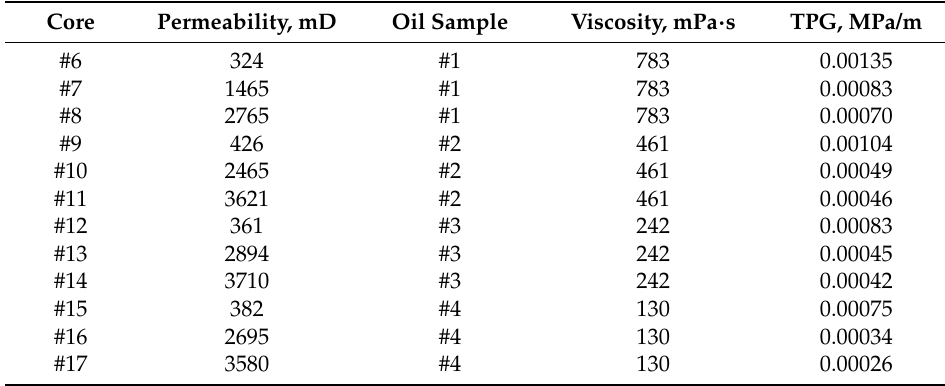
Table 5. TPG measurement results of the heavy